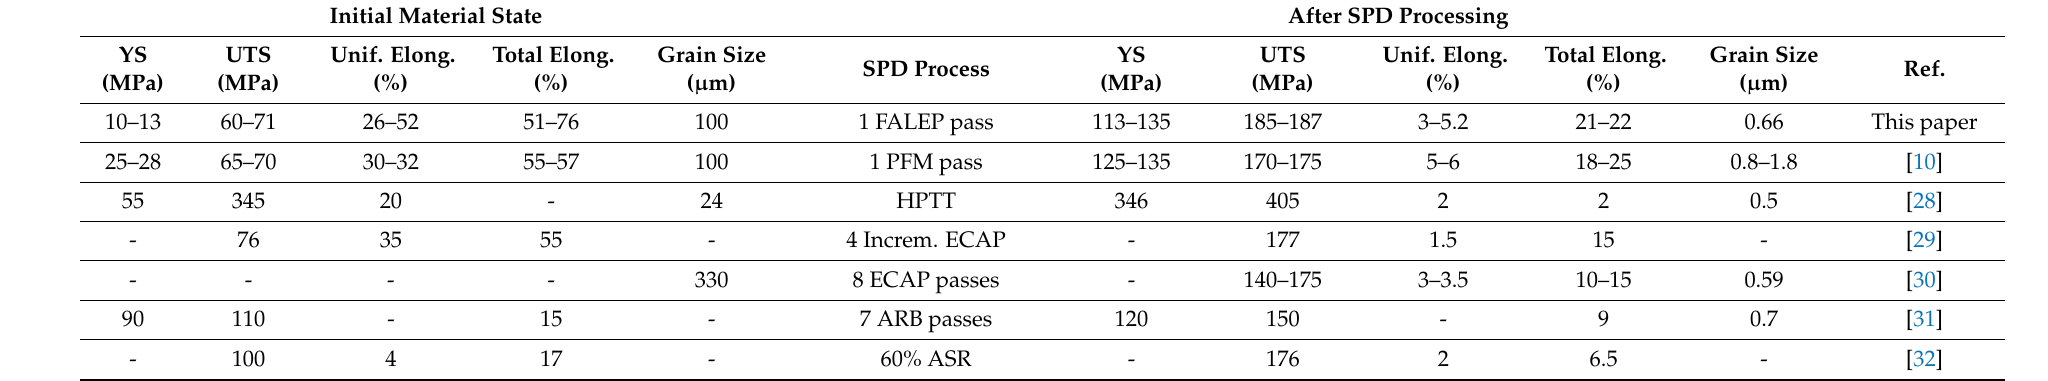
Table 3. Tensile test results on Al-1050 processed by different SPD processes. All tests were carried out at room temperature. (YS: von Mises equivalent yield strength; UTS: